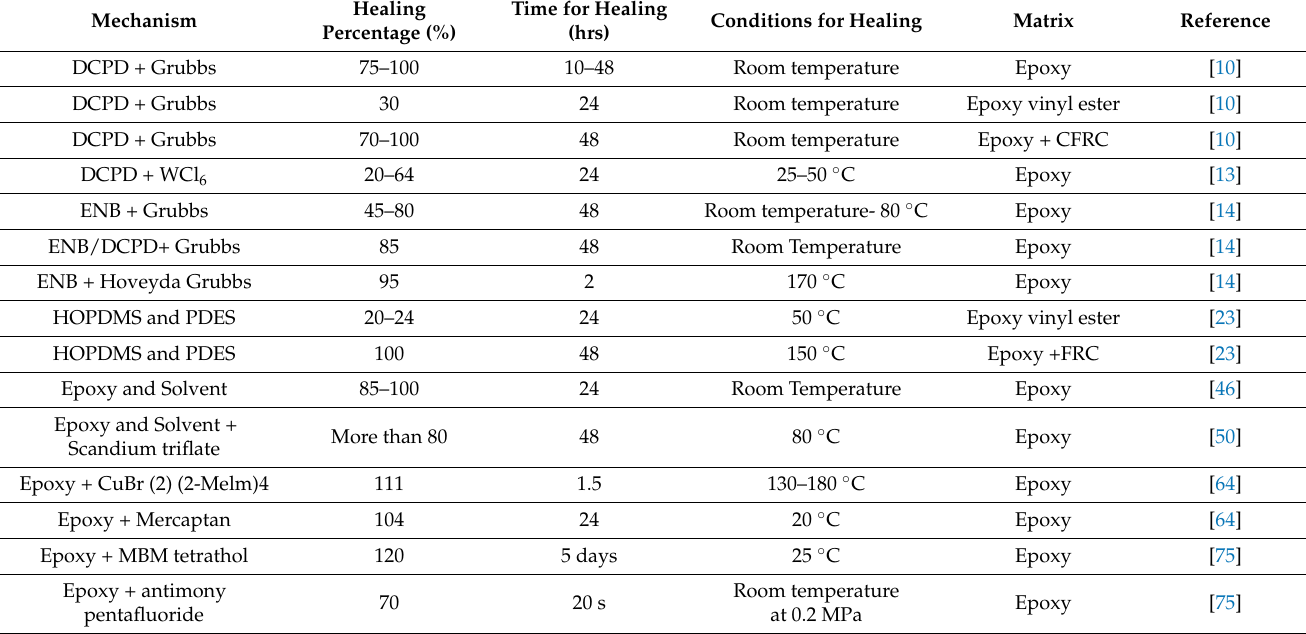
Table 2. Healing performance of capsule-based self-healing materials